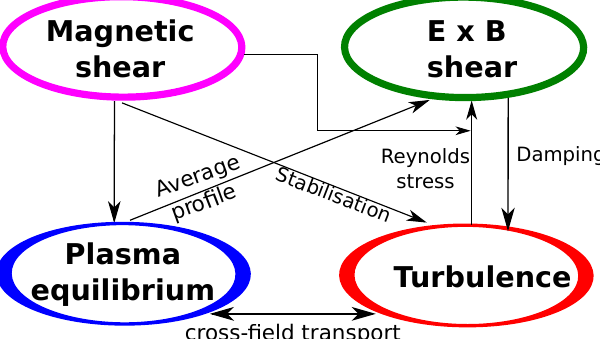
Figure 1. Sketch of the interplay of physical mechanisms intervening in the formation of transport